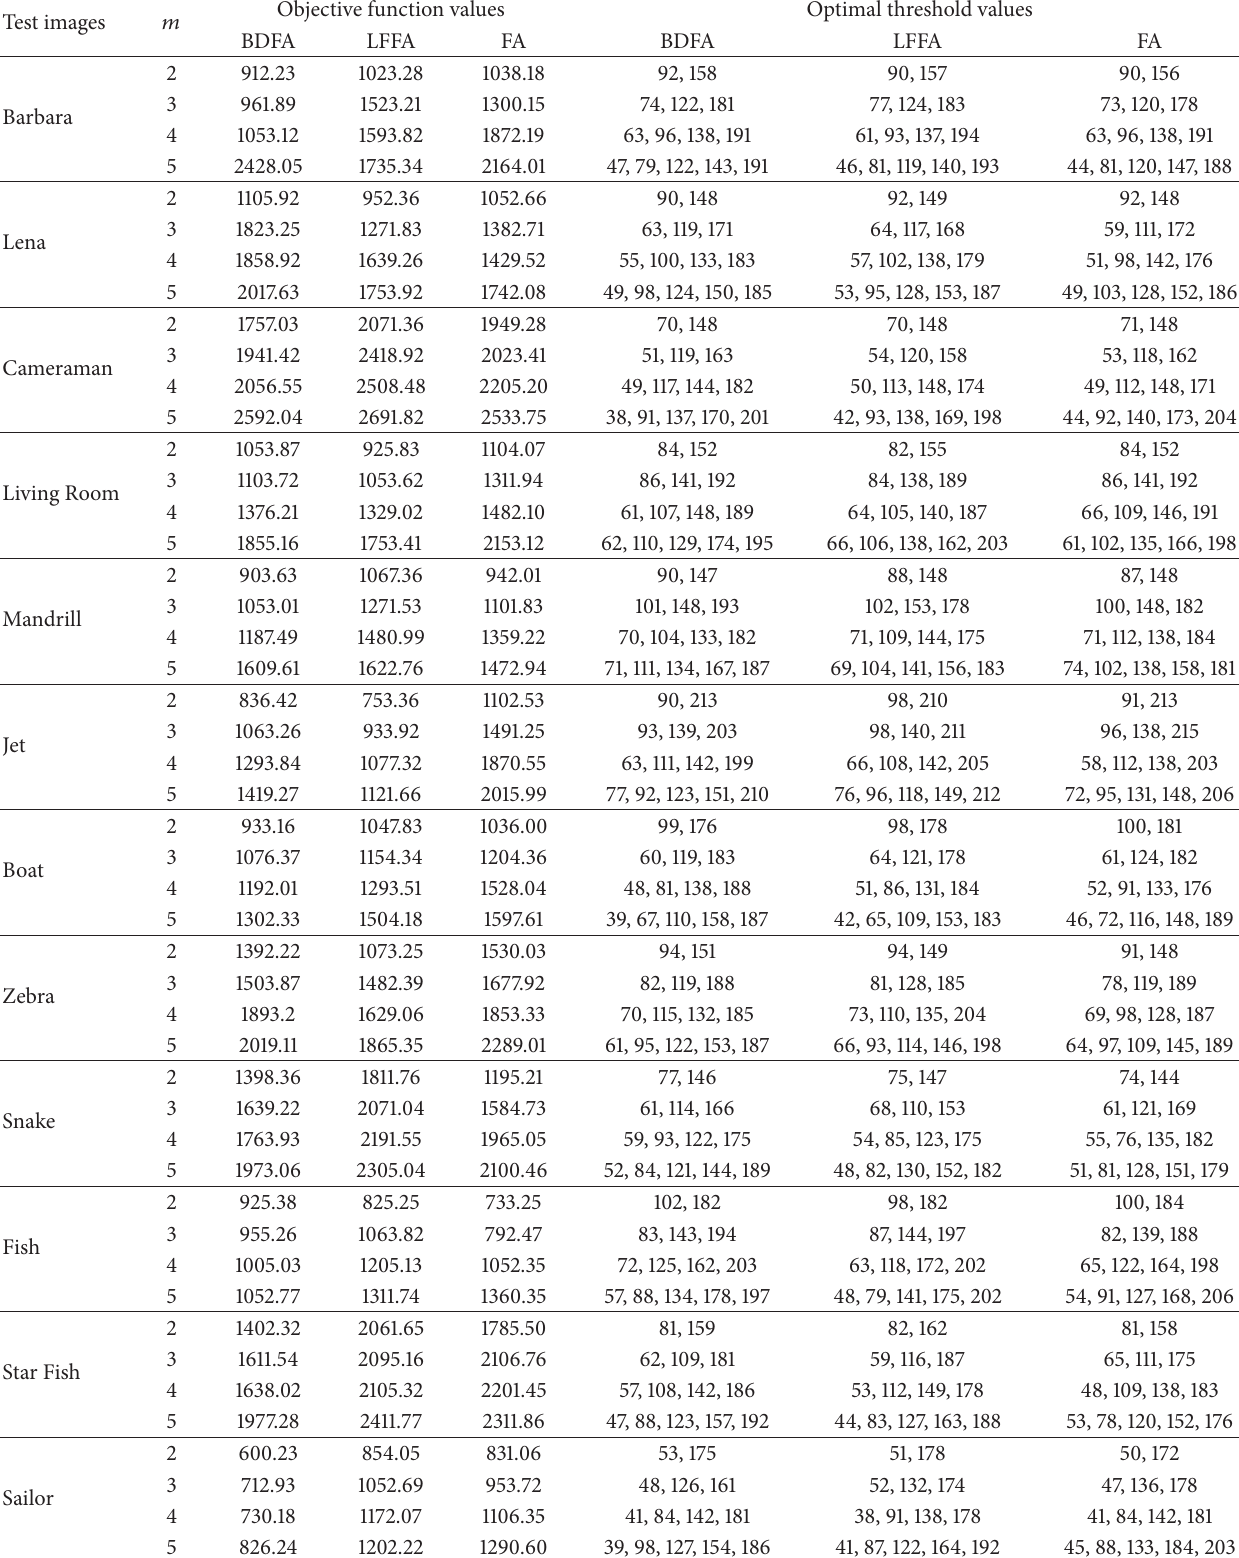
Table 1: Comparison of objective values achieved with Otsu guided various